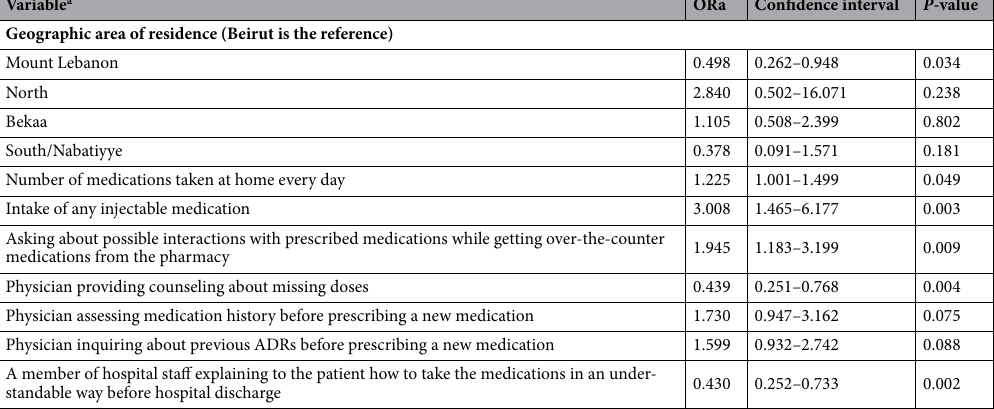
Table 3. Patients’ self-reported experience of Adverse Drug Events (ADEs)—Multivariable Analysis. a Variables with a p -value of 0.2 or less in the bivariate analysis were included in the initial model. Those include: gender; marital status; level of education; geographic area of residence; employment status; number of chronic diseases per patient; chronic kidney disease; intake of any inhaled medication; intake of any injectable medication; initiation of medication-related discussion; not taking a prescribed medication because of counter-indications mentioned in the leaflet and not mentioned by the physician during the visit; asking about possible interactions with prescribed medications while getting the OTC’s from the pharmacy; pharmacist providing counseling about drug interactions, missing doses, accidental overdose, and potential ADRs; physician providing counseling about drug interactions, missing doses, accidental overdose, and potential ADRs; physician assessing medication history before prescribing a new medication; physician inquiring